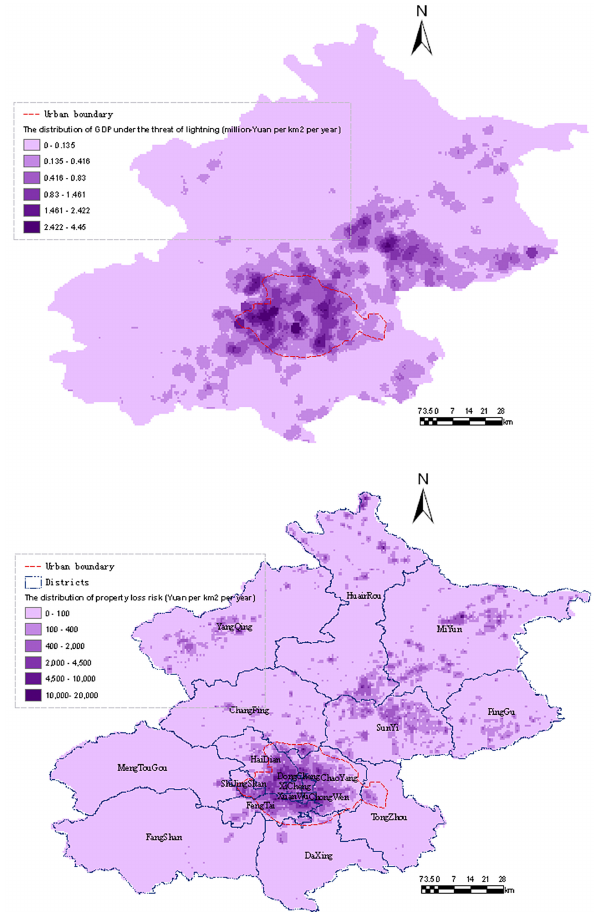
Figure 10. Zoning of (a) the amount of GDP under the threat of lightning and (b) property loss risk simulated by the